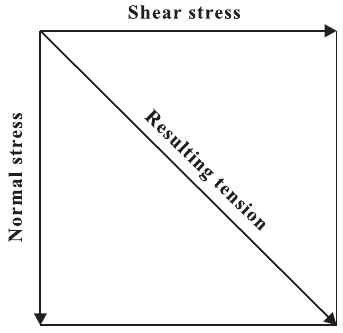
Figure 1. Scheme of tension distribution in the direct shear